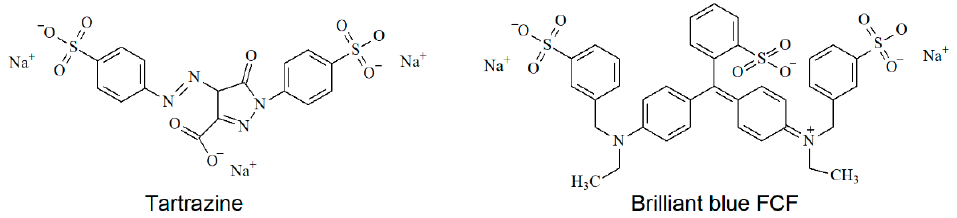
Figure 1. Structure of the synthetic dyes under consideration. The direct determination of tartrazine and brilliant blue FCF is of practical interest.